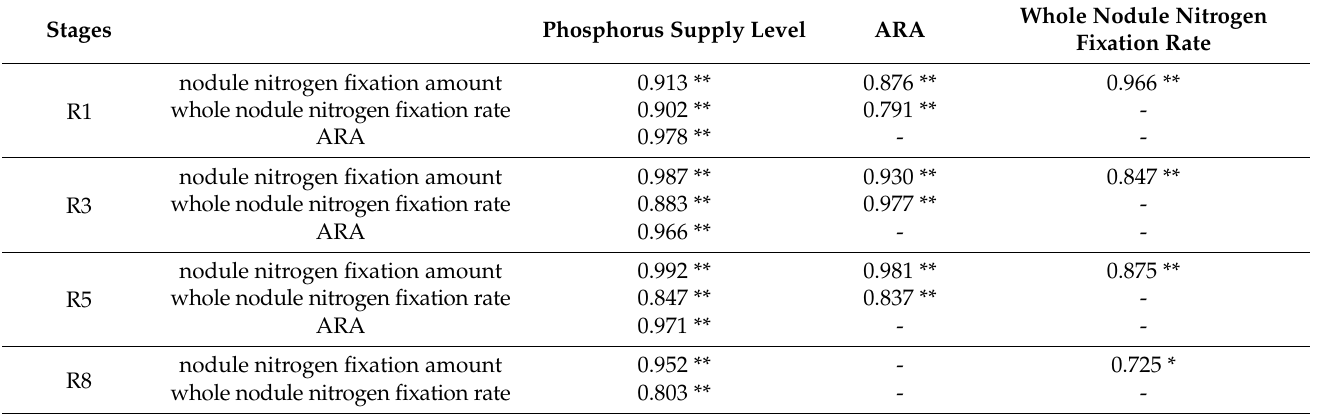
Table 6. Correlation of different phosphorus supply levels, ARA, nitrogen fixation rate of nodules, and nitrogen fixation of